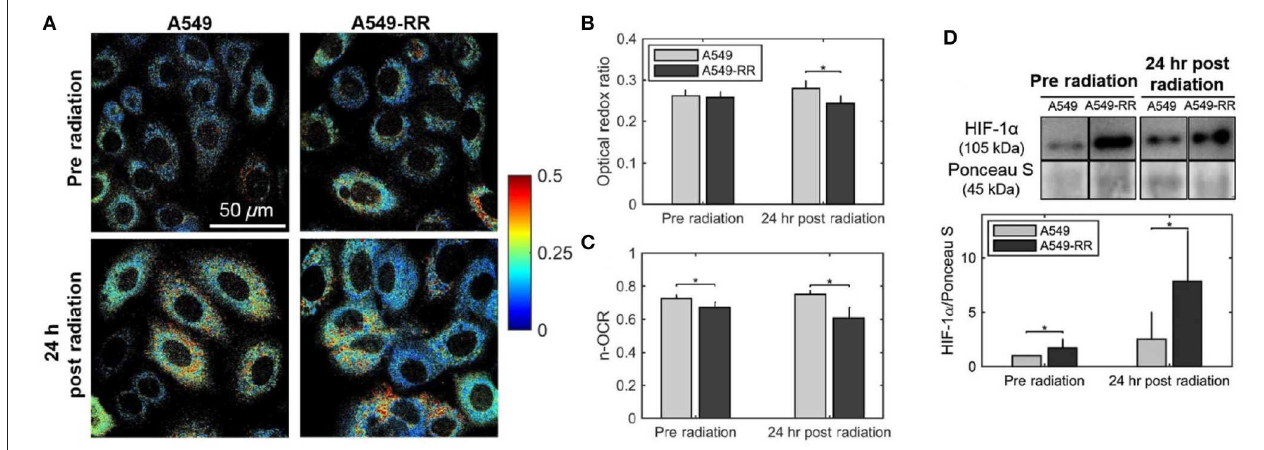
FIGURE 1 | Optical redox ratio is sensitive to radiation-induced changes in cellular metabolism. Radiation causes a decrease in the optical redox ratio after 24h in the radiation-resistant cells, indicating increased glycolytic metabolism. (A) Representative redox images of parental and radiation resistant A549 cells at baseline prior to radiation and 24h after 2Gy of radiation. (B) Quantification of redox ratio images indicates a statistically significant decrease in the optical redox ratio 24h after radiation in the A549-RR cells compared with the parental A549 cells ( p = 0.01). (C) Differences in the n-OCR (calculated as OCR/PPR) are consistent with the optical redox ratio. PPR refers to the proton production rate, which is equivalent to the extracellular acidification rate (ECAR). (D) Radiation causes a significant increase in HIF-1 in the radiation-resistant cells 24h after radiation. Western blots of HIF-1 protein expression demonstrate statistically significant differences between A549 and A549-RR cells at baseline and 24h after radiation, indicating reoxygenation-induced HIF-1 expression in the A549-RR cells. Asterisks placed above bars indicate statistical significance. Error bars in (B,C) , and (D) represent standard deviation of the mean plate value. Adapted with permission from Alhallak et al. (